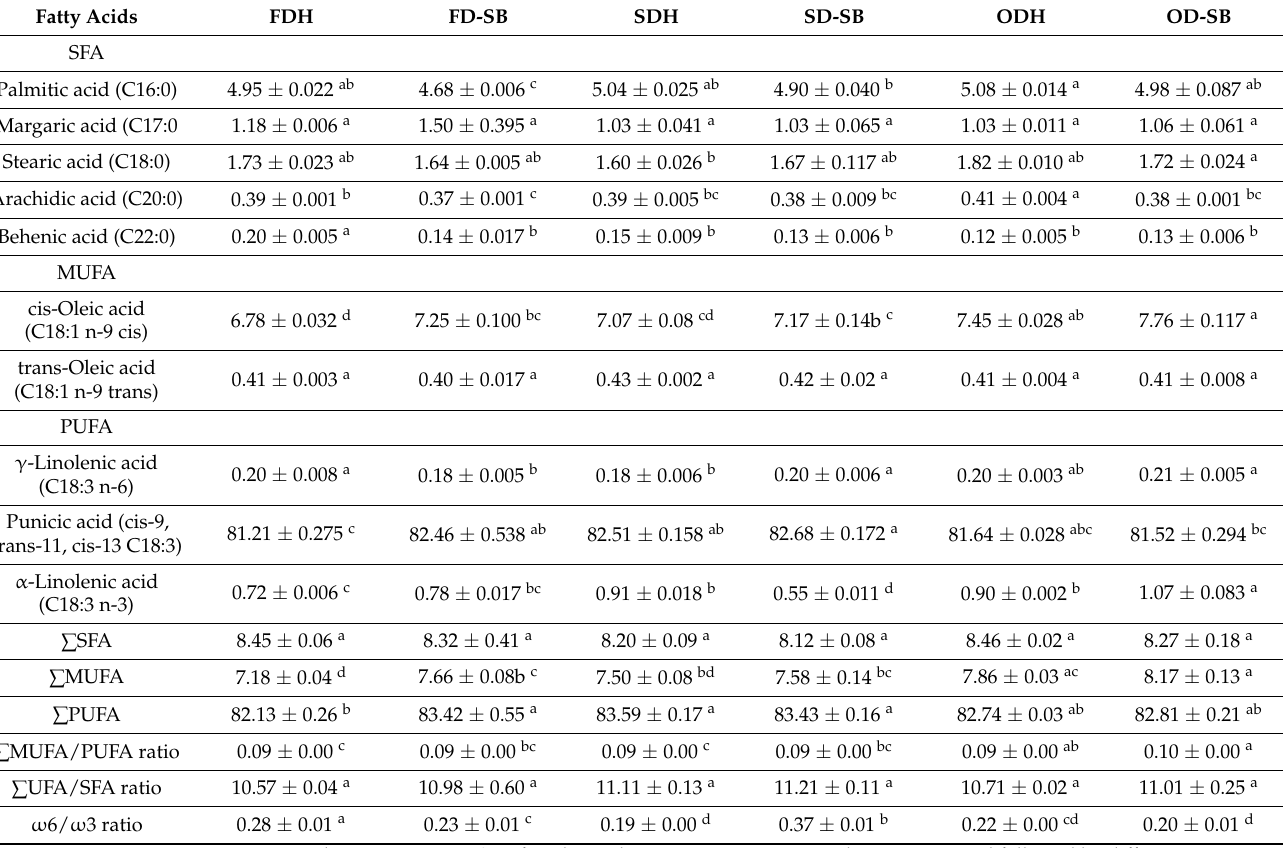
Table 3. Fatty acid composition (%) of oil from seeds of healthy and sun-burned fruits and dried under different drying methods.